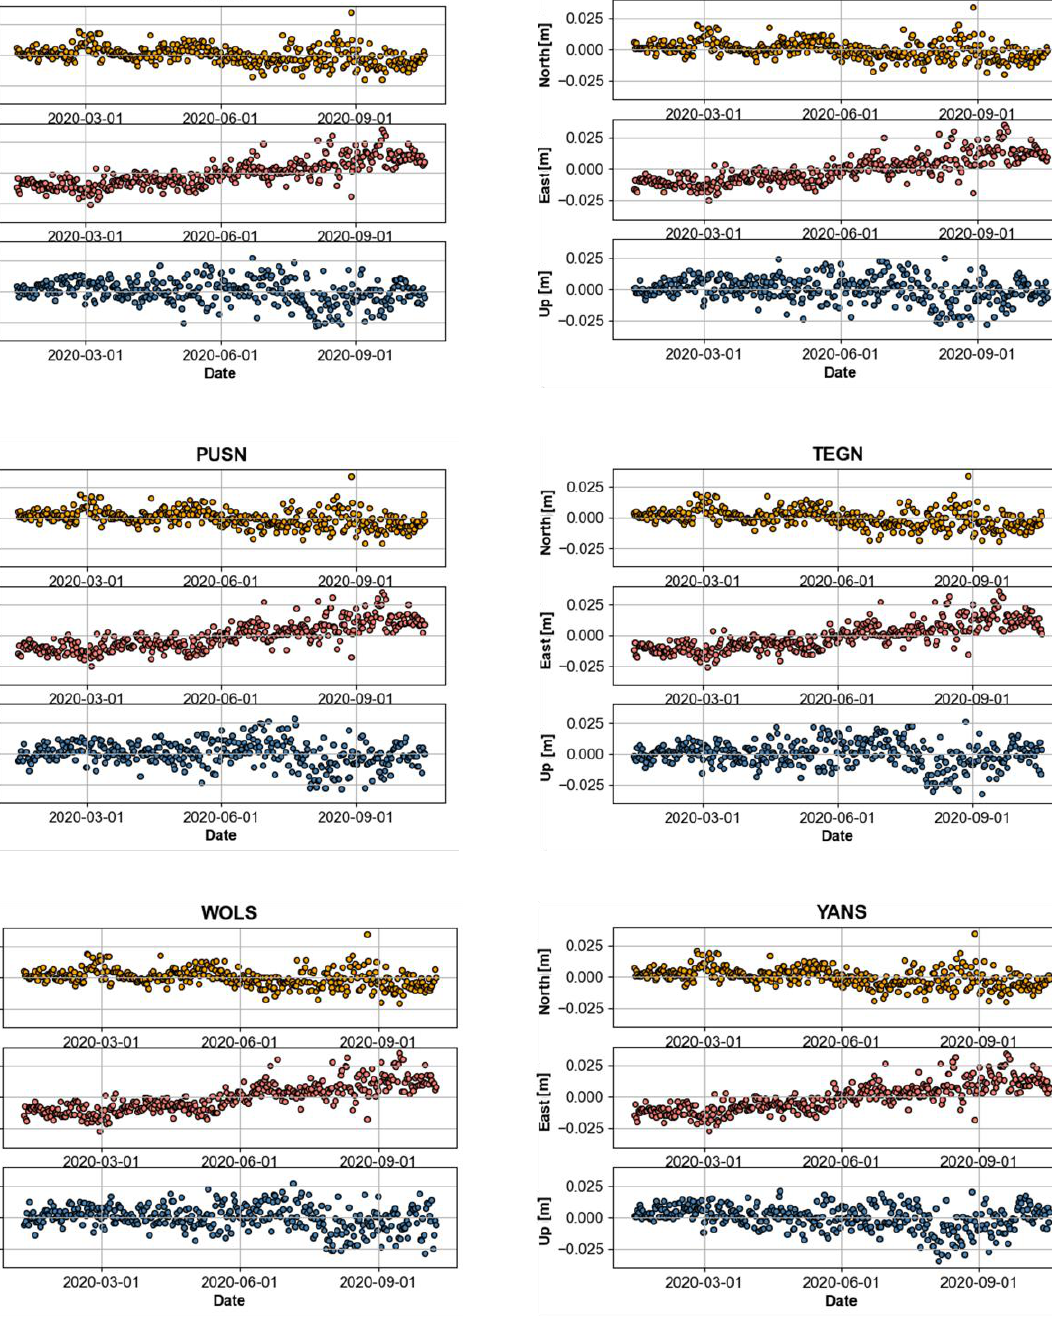
Figure A3. Time series GNSS Station in 2020.